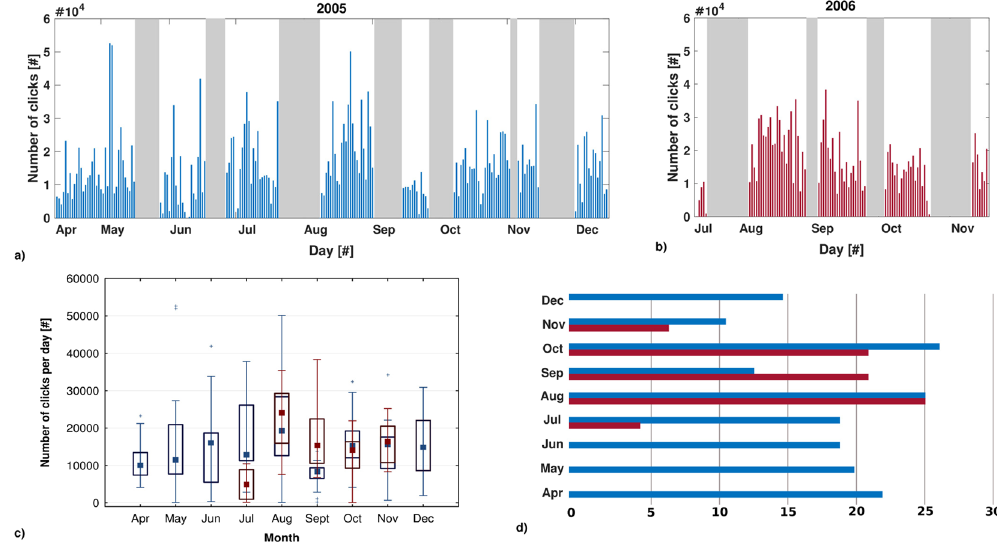
Figure 6. Number of clicks recorded per day (5 min/h) ( a , b , c ). ( a ) 2005, from 9 th April to 15 th December (3,736 files); ( b ) 2006, from 11 th July to 14 th November (1,758 files); days in which the O ν DE station did not acquire data are showed in grey. ( c ) In each box (blue: 2005; red: 2006), the central mark indicates the median, and the bottom and top edges of the box indicate 25 th and 75 th percentiles, respectively. Whiskers extend to the most extreme data points not considered outliers, and outliers are plotted individually using the ‘ + ’ symbol. ( d ) Acquisition effort in number of days of recordings per month over the two